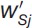
Model Architecture.
A, The model consists of a sensory input layer with units that code the input (instantaneous units) and transient units that only respond when a stimulus appears (on-units) or if it disappears (off-units). The association layer contains regular units (circles) with activities that depend on instantaneous input units, and integrating memory units (diamonds) that receive input from transient sensory units. The connections from the input layer to the memory cells maintain a synaptic trace (sTrace; blue circle) if the synapse was active. Units in the third layer code the value of actions (Q-values). After computing feed-forward activations, a Winner-Take-All competition determines the winning action (see middle panel). Action selection causes a feedback signal to earlier levels (through feedback connections wSj′, see middle panel) that lays down synaptic tags (orange pentagons) at synapses that are responsible for the selected action. If the predicted Q-value of the next action S′ (QS′) plus the obtained reward r(t) is higher than QS, a globally released neuromodulator δ (see eq. (17)) interacts with the tagged synapses to increase the strength of tagged synapses (green connections). If the predicted value is lower than expected, the strength of tagged synapses is decreased. B, Schematic illustration of the tagging process for regular units. FF is a feed-forward connection and FB is a feedback connection. The combination of feed-forward and feedback activation gives rise to a synaptic tag in step ii. Tags interact with the globally released neuromodulator δ to change the synaptic strength (step iv,v). C, Tagging process for memory units. Any presynaptic feed-forward activation gives rise to a synaptic trace (step ii; sTrace—purple circle). A feedback signal from the Q-value unit selected for action creates synaptic tags on synapses that carry a synaptic trace (step iv). The neuromodulator can interact with the tags to modify synaptic strength (v,vi).